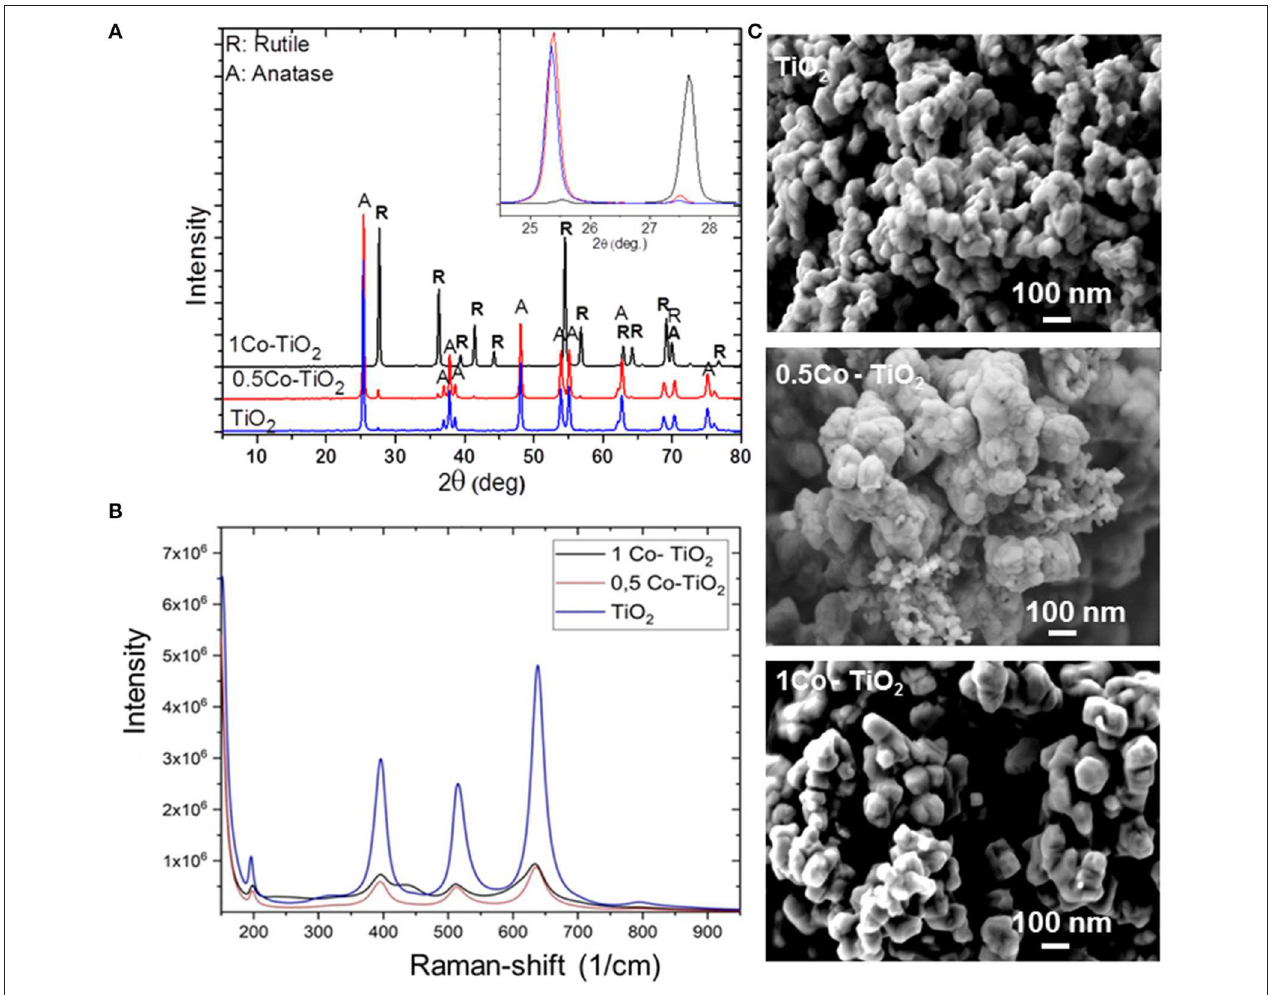
FIGURE 1 | (A) Powder XRD patterns of undoped and Co-doped TiO 2 , (B) Raman spectra of undoped and Co-doped TiO 2 , (C) SEM images of undoped and Co-doped TiO 2